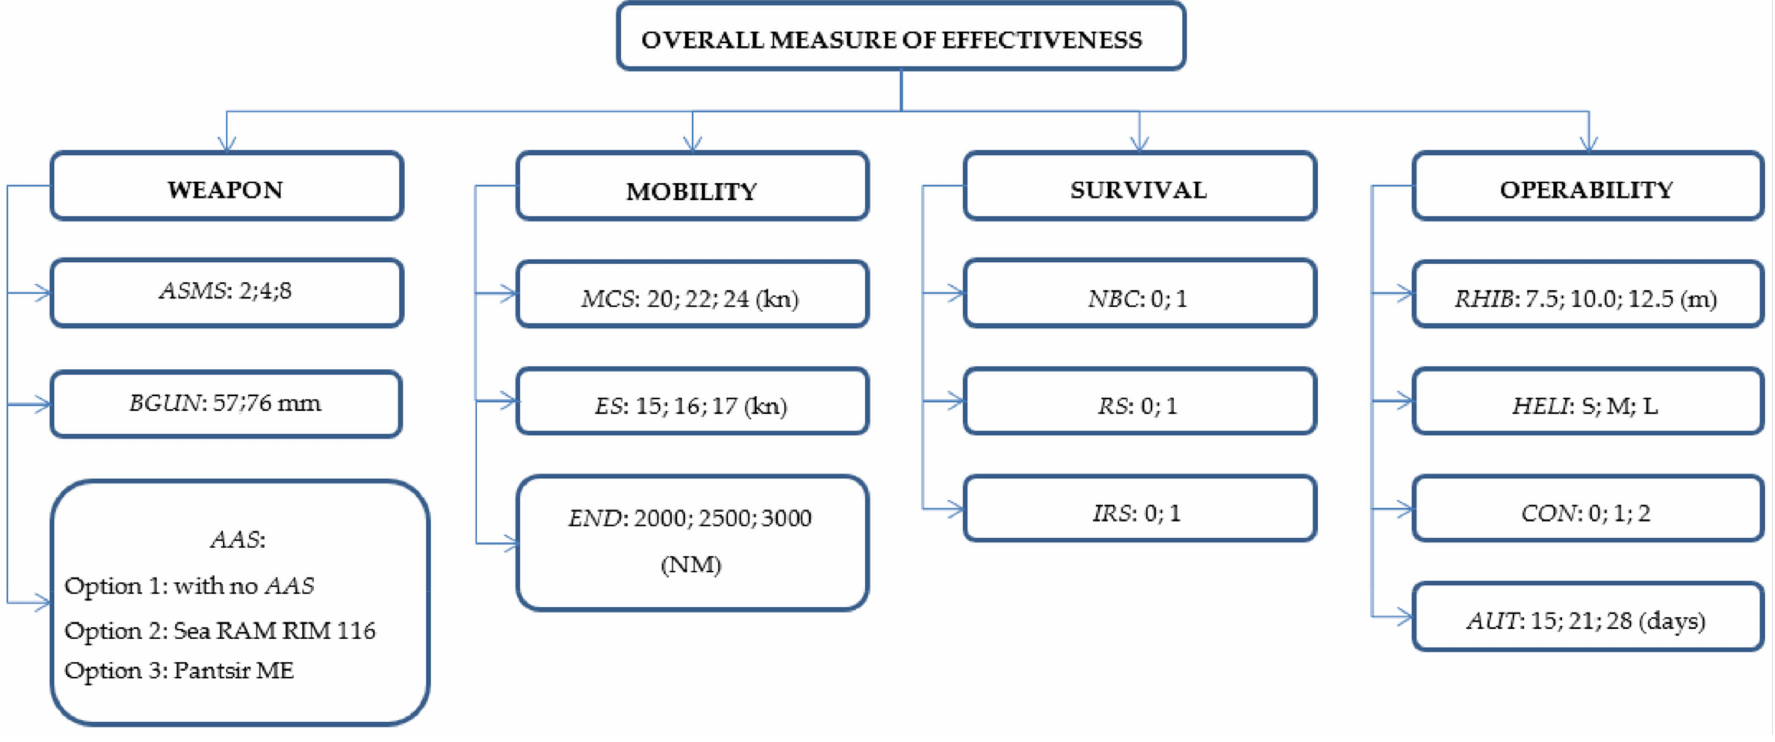
Figure 1. Analytic hierarchy structure of specific